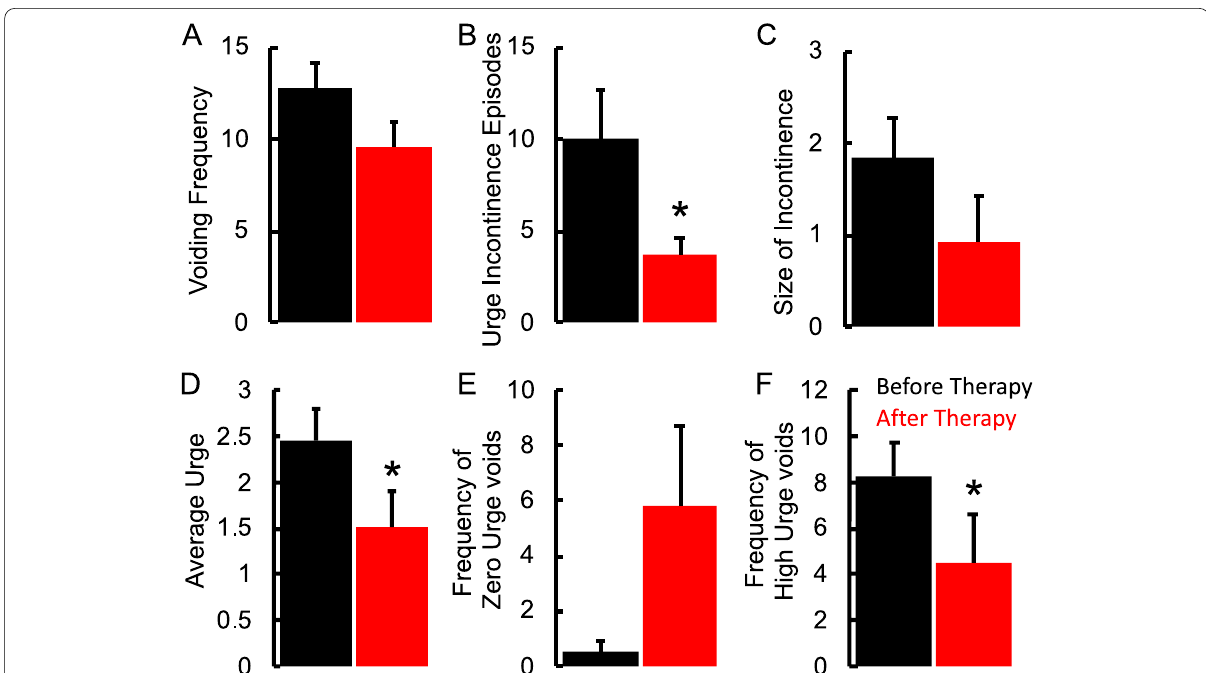
Fig. 2 Voiding diary characteristics. A Mean SE ( n 8) total voiding frequency, B Mean ± = day, C Mean SE ( n 7) size of each incontinence episodes per day (Incontinence episodes were classified on a scale of 0 to 3, where 0 ± = leak or dry pad/diaper, 1 Small leak, 2 Moderate leak and 3 Heavy leak), D Mean = = = ( n 8) frequency of zero urge voids and F Mean SE ( n 8) voiding frequency with high urge (levels 2 or higher; urgency rating for each void = ± = self-classified by the patient on a scale of 0 to 4, as follows: 0